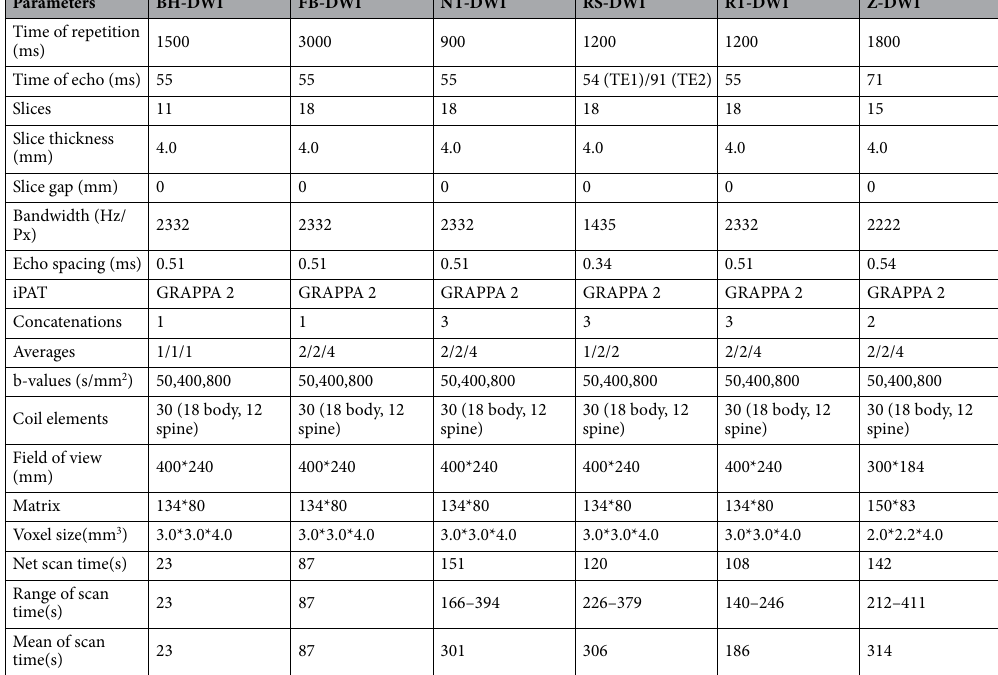
Table 6. The summarized parameters of all DWI sequences in our study. BH-DWI breath-hold DWI, FB-DWI free-breathing DWI, NT-DWI navigator-triggered DWI, RS-DWI readout-segmented DWI, RT-DWI respiratory-triggered DWI, Z-DWI Zoomit DWI, iPAT integrated parallel acquisition technique, GRAPPA generalized autocalibrating partially parallel acquisition, Concatenations group